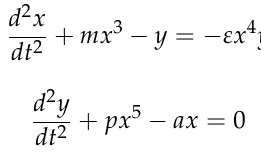
Figure 4. The error in period’s calculation if using Equation (30) with respect to the exponent n of the power law elastic